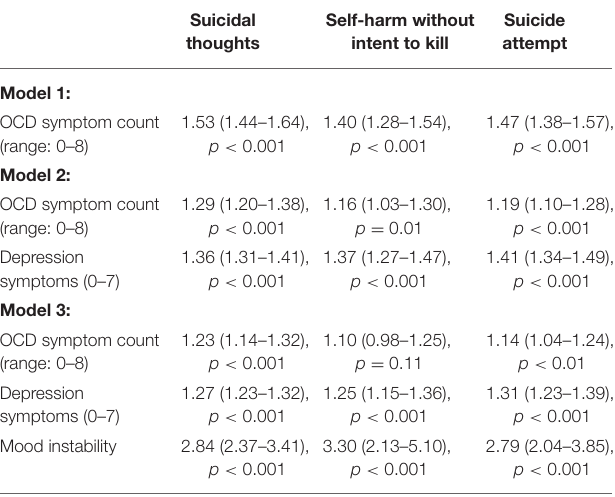
TABLE 2 | Weighted logistic regression models: OCPD traits and suicide-related outcomes (Odds Ratios, 95% CI, p -value). Suicidal